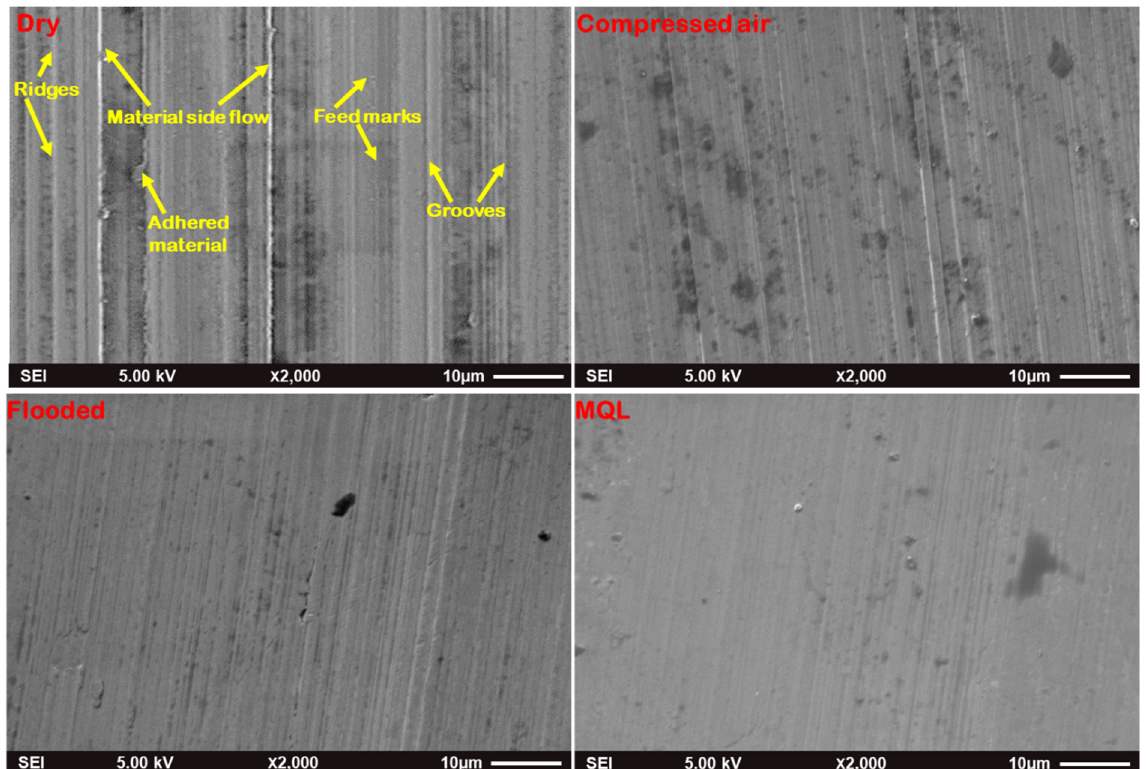
Figure 13. SEM micrographs of machined surface at v = 87 m/min, f = 0.12 mm/rev under different cooling lubrication methods.